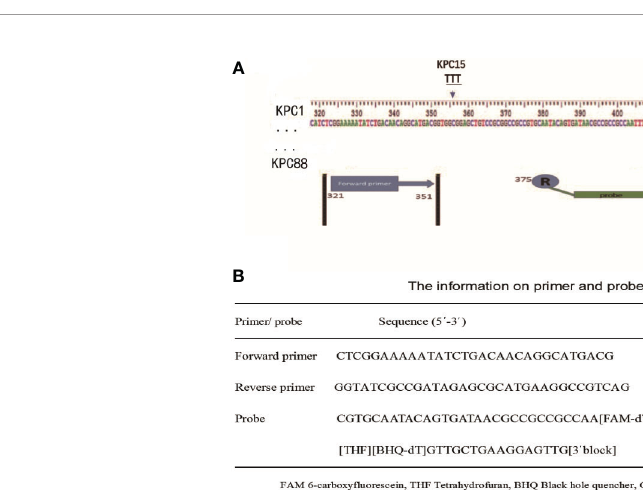
FIGURE 1 | Selection of speci fi c regions and primer positions. (A) A total of 87 bla KPC genes ( bla KPC-1 to bla KPC-82 and bla KPC-84 to bla KPC-88 ) were released in the NCBI website, and bla KPC83 was not released. The primers and probe sets were designed within the highly conserved regions of 87 bla KPC genes (320-472 bp region) by avoiding two mutation regions of bla KPC-15 . (B) The primer and probe sequences used for RAA